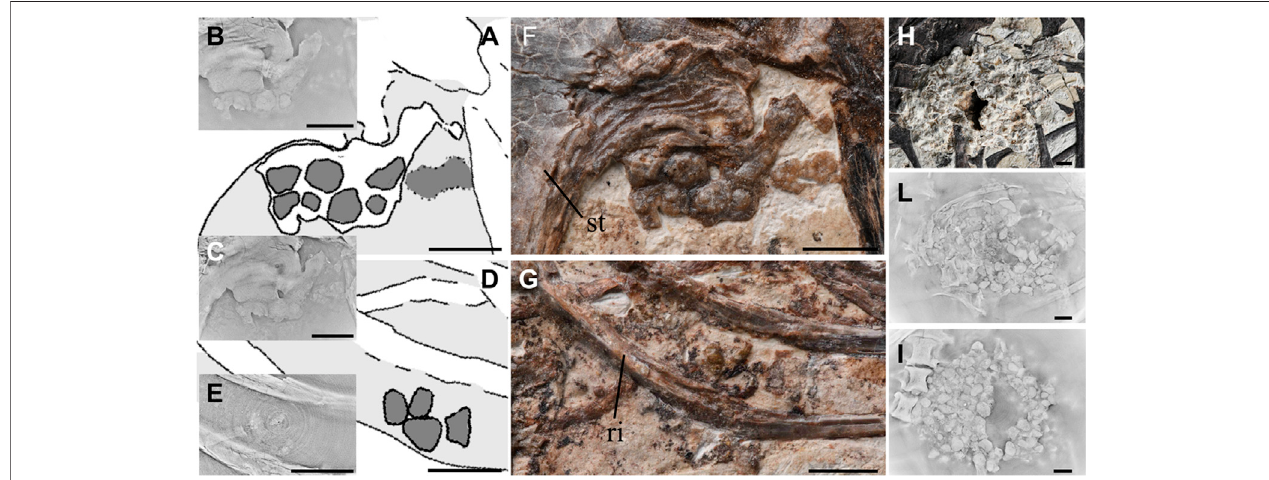
FIGURE 1 | Description and comparison of purported gastroliths and true gizzard stones further illuminated with the aid of CL. (A,D) . Line drawing from Li et al. (2015) of the purported gastroliths of Bohaiornis IVPP V17963 near the sternum (A) and between the thoracic ribs (D) (Li et al., 2015); (B,C) . CL scans results of gastroliths depicted in (A) from two different levels showing the interconnectedness of the purported gastroliths; (E) . CL scans result corresponding to (D) depicting the weakimpressionsofthepurportedgastroliths; (F) .Photographofpurportedgastrolithsof Bohaiornis IVPPV17963nearthesternum; (G) .Photographofpurported gastroliths of Bohaiornis IVPP V17963 between two thoracic ribs; (H) . Photograph of the gastral mass preserved Archaeorhynchus IVPP V17075; (L,I) . Two location of CL scans corresponding to (H) , both revealing distinctly separated individual gastroliths. Anatomical abbreviations: st, sternum; ri, rib. Scale bar equals fi ve